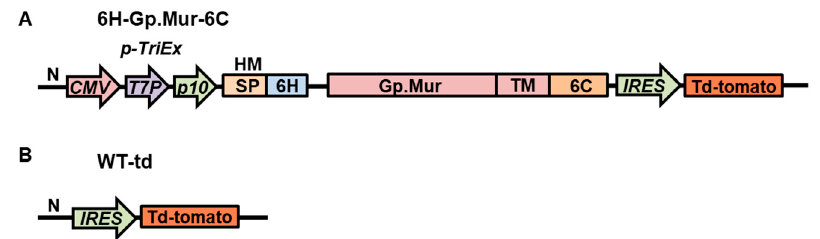
Figure 1. Construction of recombinant baculovirus expressing Gp.Mur antigen. ( A ) 6H-Gp.Mur-6C encodes the Gp.Mur extracellular domain and its transmembrane domain (TM) fused with the 6C. ( B ) Wild-type baculovirus with the reporter gene alone (WT-td). The 6H-Gp.Mur-6C construction is fused to hexameric histidine tag (6H). p-TriEx : composite promoter; CMV : mammalian CMVie promoter; T7P : bacterial T7 promoter; p10 : baculovirus p10 promoter; HM: honeybee melittin; SP: signal peptide; IRES : Rhopalosiphum padi virus internal ribosomal entry site; Td-tomato: td-tomato reporter gene.